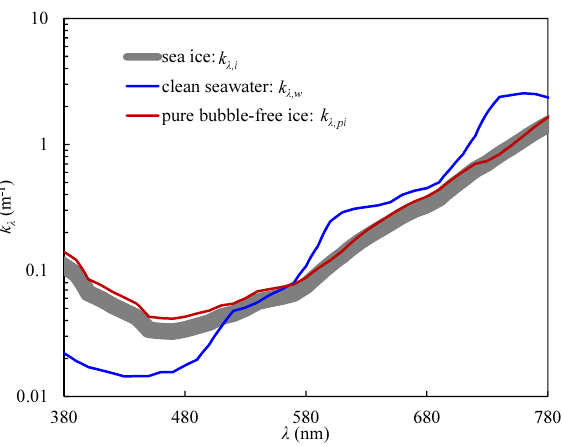
Figure 3. Absorption coefficients of clean seawater, pure bubble- free ice and sea ice in the visible band. The water data are from Smith and Baker (1981). The pure ice data are from Grenfell and Perovich (1981) and Warren (1984). The k λ, i value was calculated from k λ, i = ν pi k λ, pi + ν bp k λ, w , based on the volume fractions ν pi ≥ 60% and ν bp ≤ 20% ( ν pi + ν bp ≤ 100%) from field observations of summer Arctic sea ice (Huang et al.,